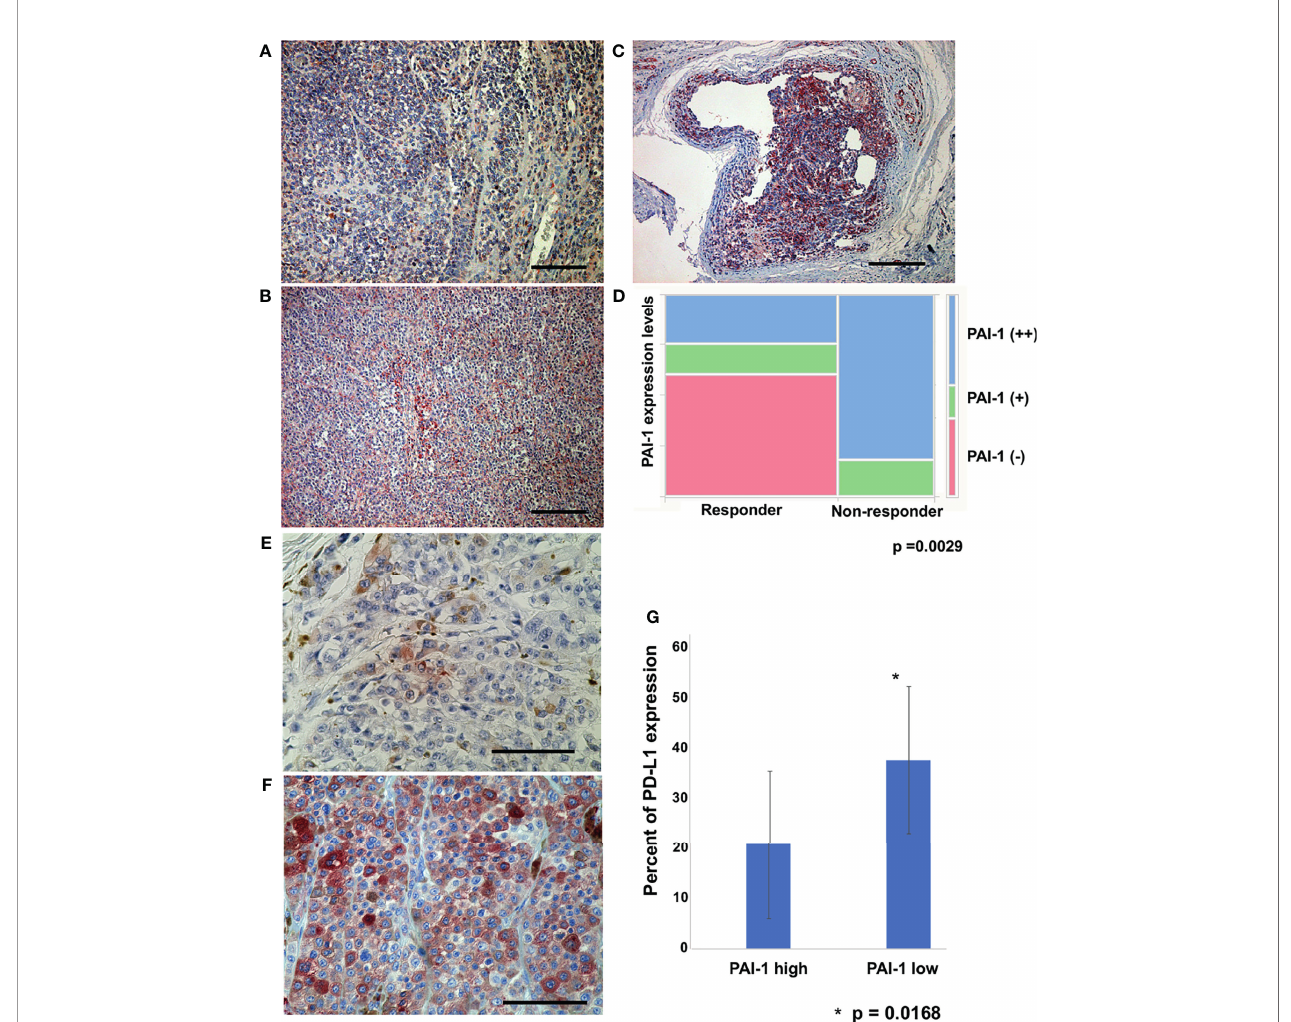
FIGURE 1 | PAI-1-expressing cells in melanoma patients. Representative paraf fi n-embedded tissue samples from lesional skin of patients with melanoma. Sections were deparaf fi nized and stained with anti-PAI-1, then developed with liquid permanent red. PAI-1 negative (-) (A) , weakly positive (+) (B) , and intensely positive (++) (C) . Scale bar, 100 µm. Pearson ’ s correlation coef fi cient was used to investigate the correlation between therapeutic effect and PAI-1 expression level (D) . Sections of melanoma from an anti-PD1 Abs in a high PAI-1 expression patient (E) and a low PAI-1 expression patient (F) were deparaf fi nized and stained using anti-PD-L1 antibodies. Sections were developed with liquid permanent red. The percentages of PD-L1+ cells per all melanoma cells were automatically counted by BZ-X800 (G) . Scale bar, 100